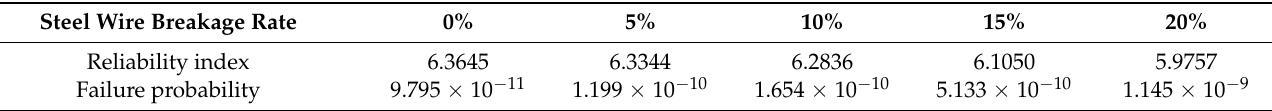
Table 9. Static wind instability probability corresponding to different steel wire breakage rates.